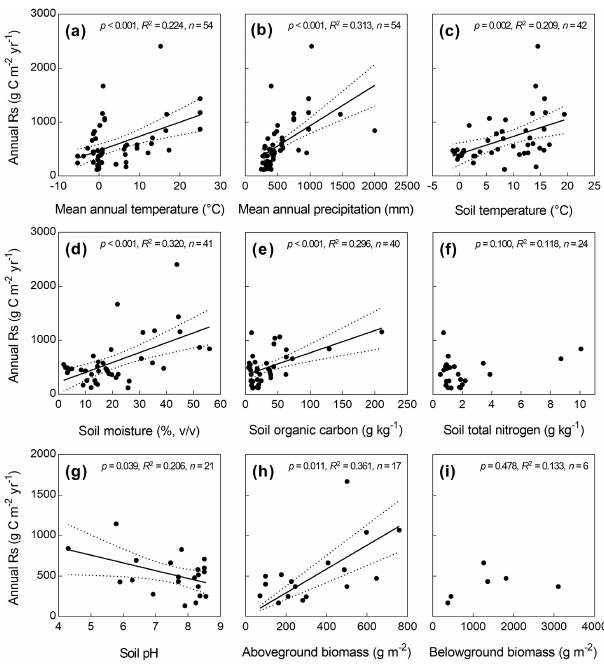
Figure 2. Relationships of annual soil respiration ( R s ) with abiotic and biotic factors. The dashed lines represent the 95% confidence interval. When the p value was greater than 0.05, the regression lines were not